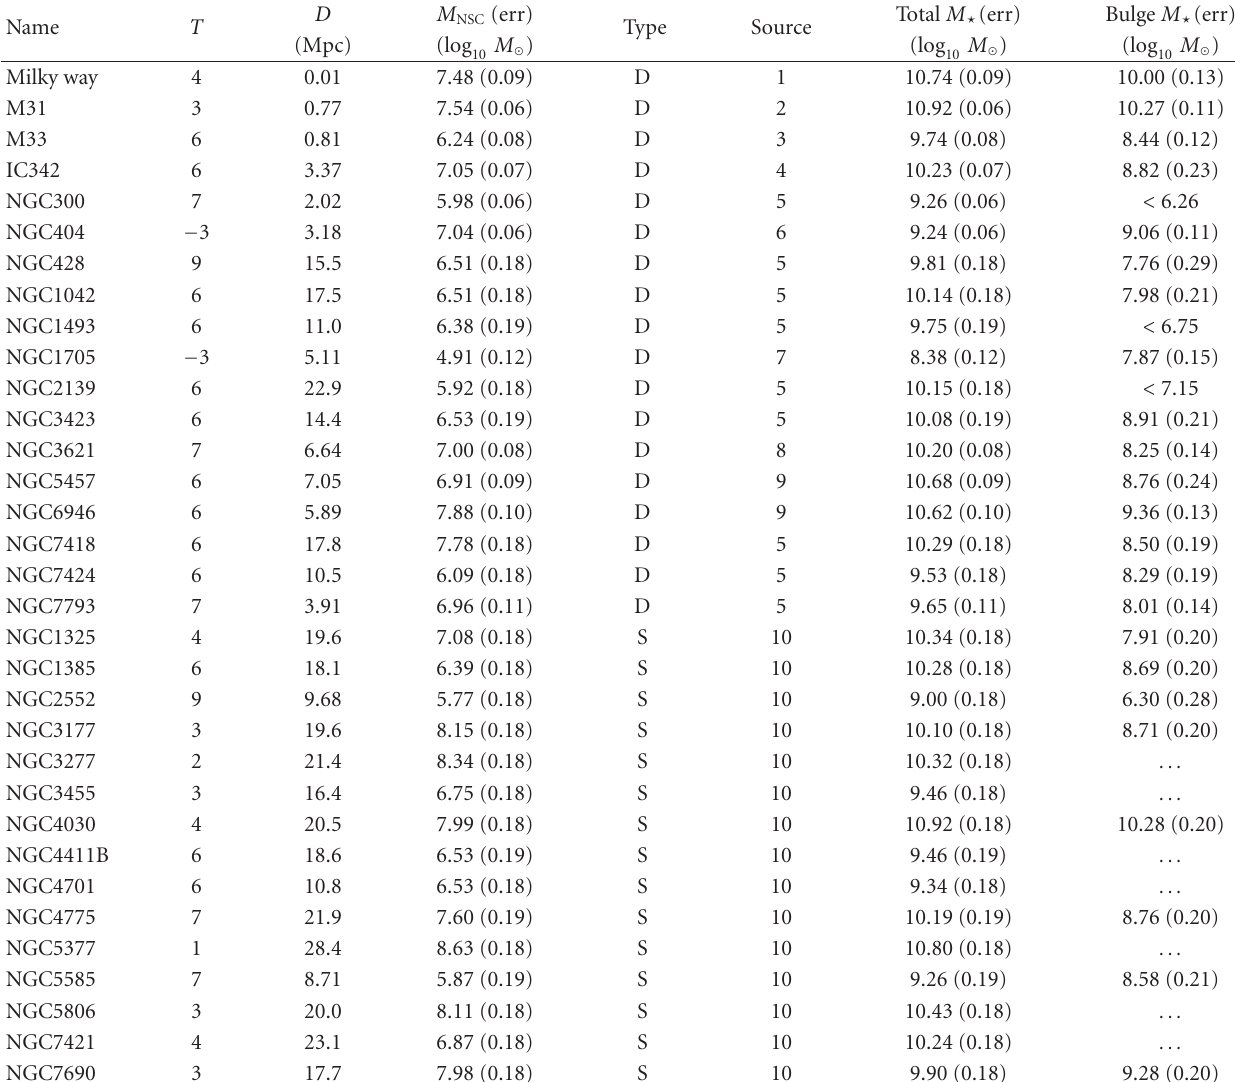
Table 2: Galaxies with well-determined NSC